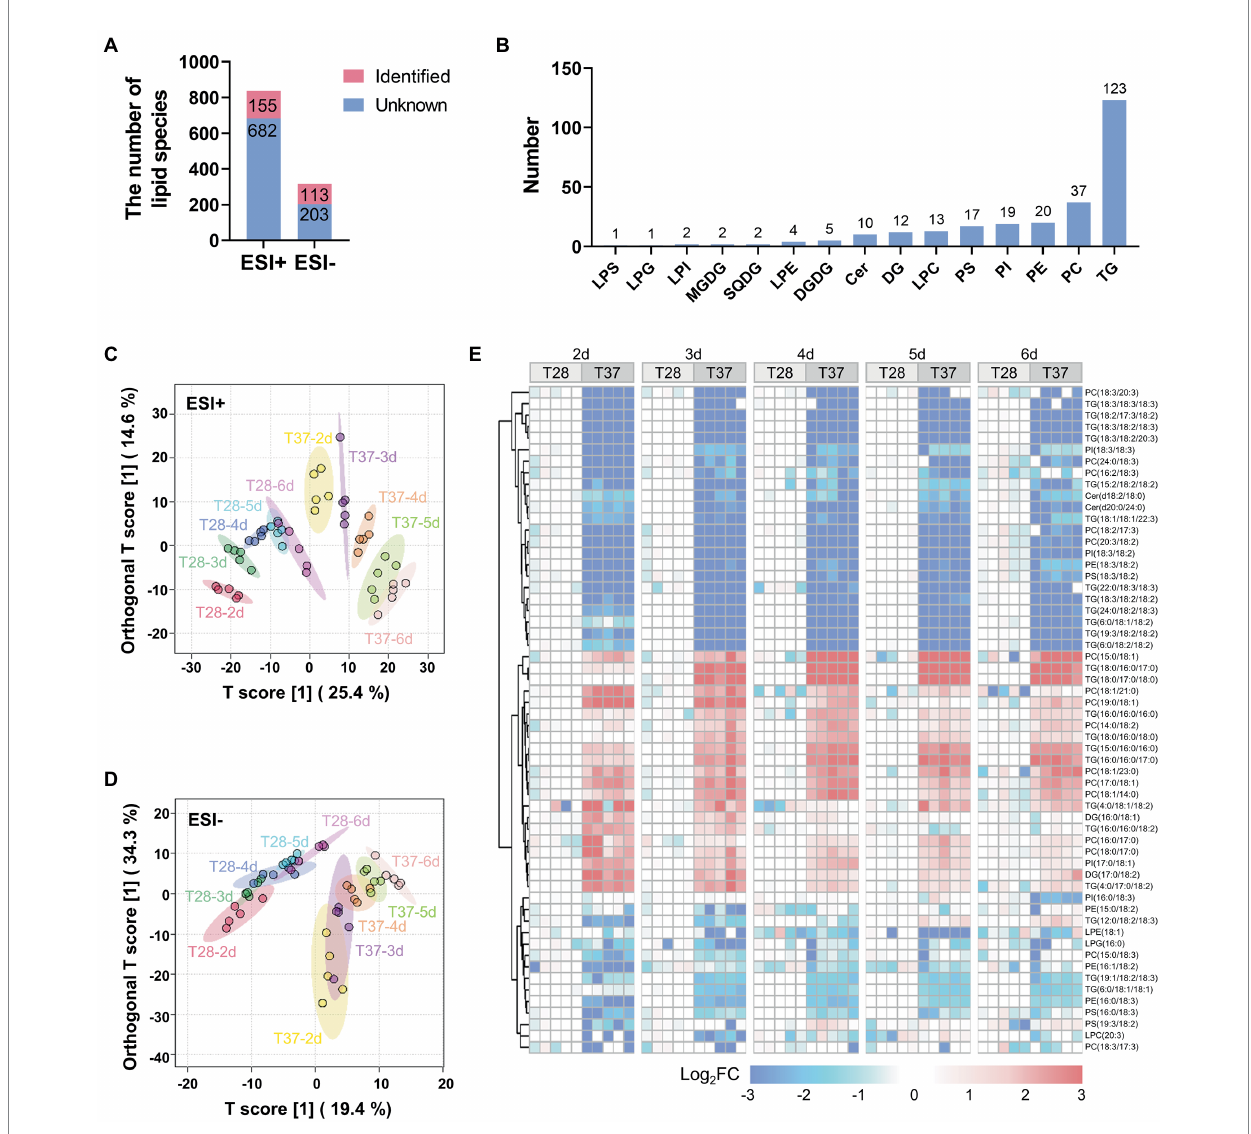
FIGURE 4 Multivariate statistical analysis of lipidomic data from A. flavus . (A) Bar diagrams showing the number of peaks detected and lipids identified by LC–MS both in the positive and negative ion modes. (B) The number of identified lipid species in different classes. (C) OPLS-DA score plots of lipidome in mycelia samples detected by LC–MS in the positive ion mode. (D) OPLS-DA score plots of lipidome in mycelia samples detected by LC–MS in the negative ion mode. (E) Heat map showing Log 2 FC values for 58 lipids differentially accumulated between the T28 and T37 mycelia